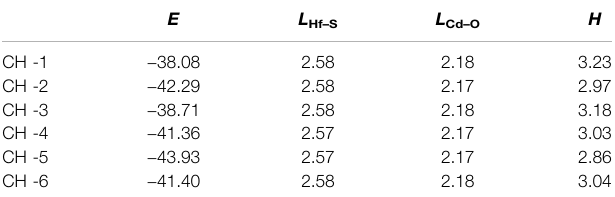
TABLE 1 | The calculated binding energy ( E , eV), bond length ( L , Å), and the thickness of interface ( H , Å) of the optimized CdO/HfS 2 heterostructure constructed by different stacking